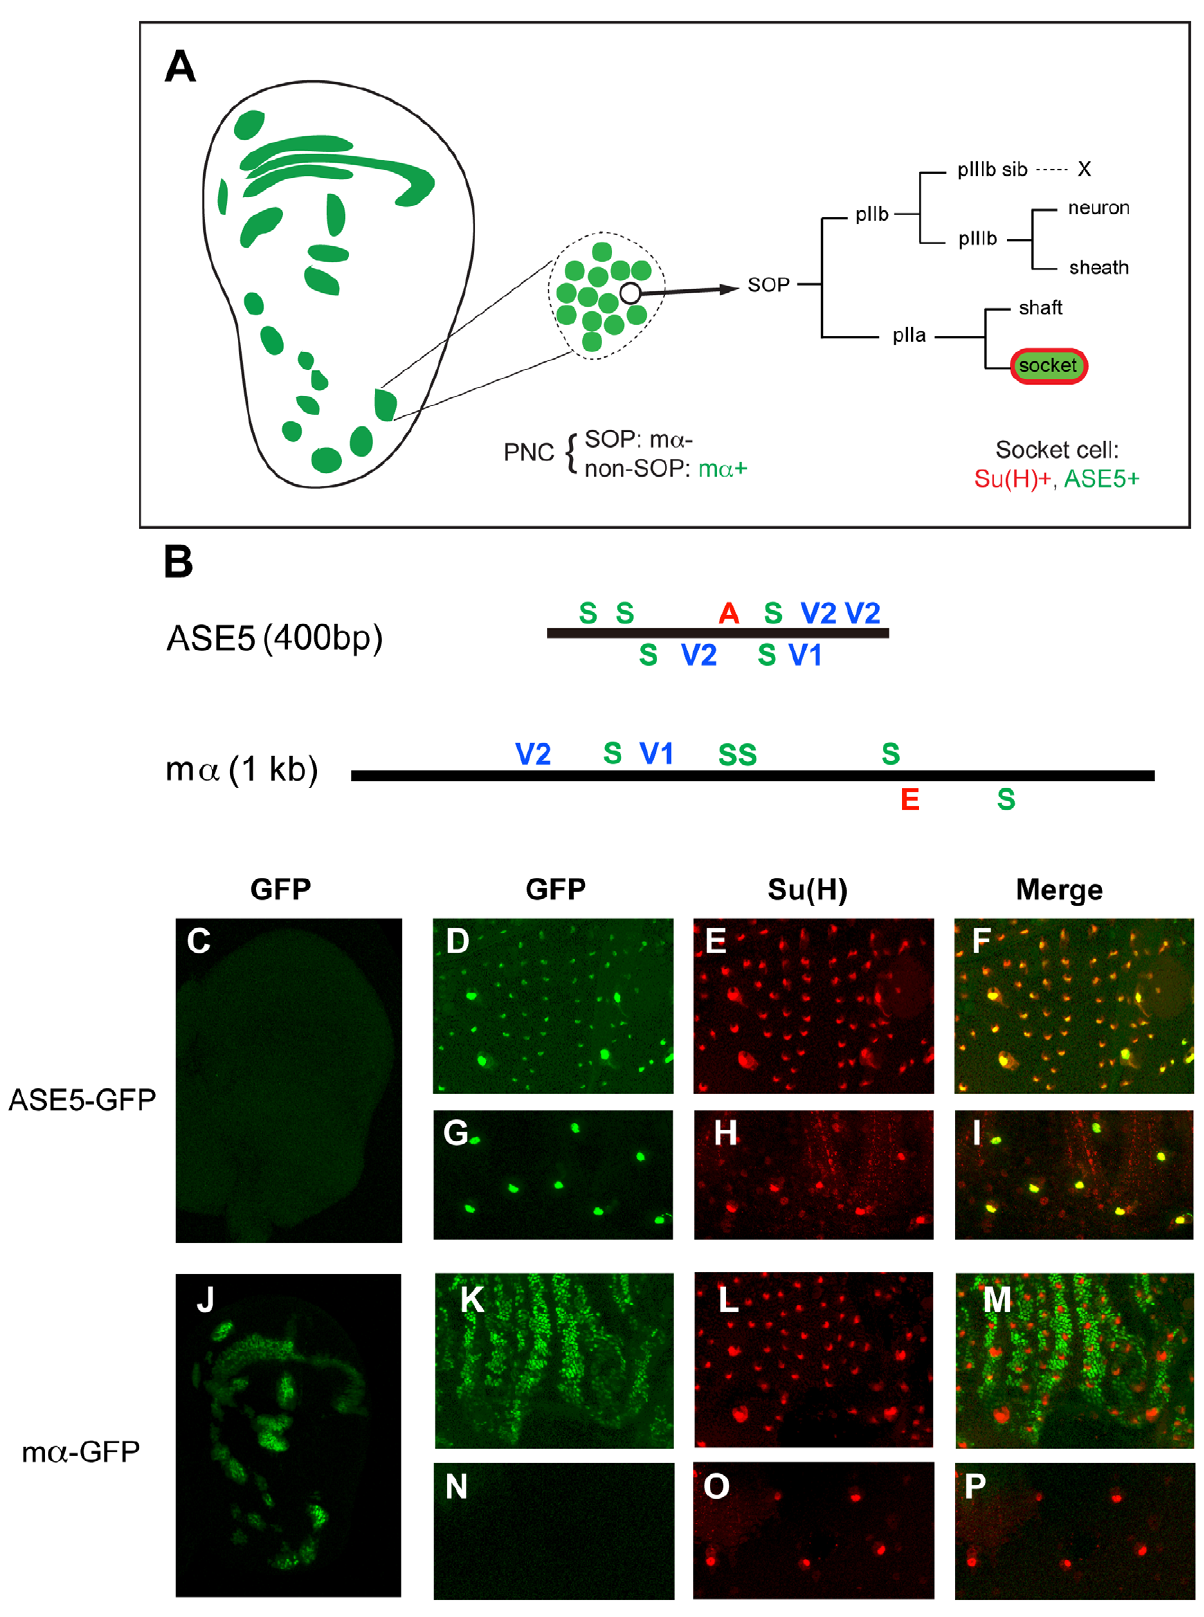
Figure 1. ASE5 and the m a enhancer are active in distinct cell types in development. (A) Diagram showing the relationship between the expression specificities of the m a enhancer and ASE5. Drawing at left represents a late third-instar wing imaginal disc; expression territories of the m a enhancer are shown in green. This enhancer is active primarily in proneural clusters (PNCs), each of which gives rise to a sensory organ precursor